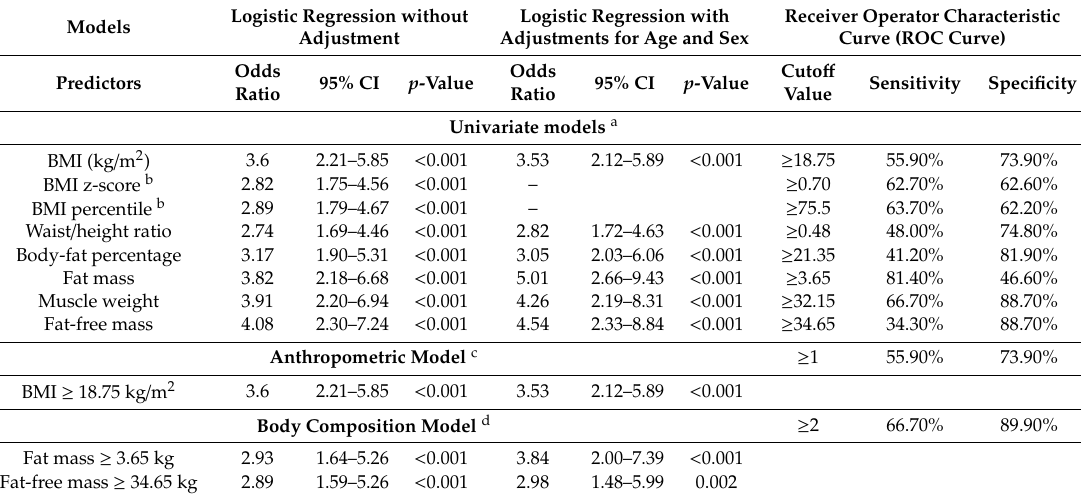
Table 4. Prediction models of pediatric hypertension in the overall